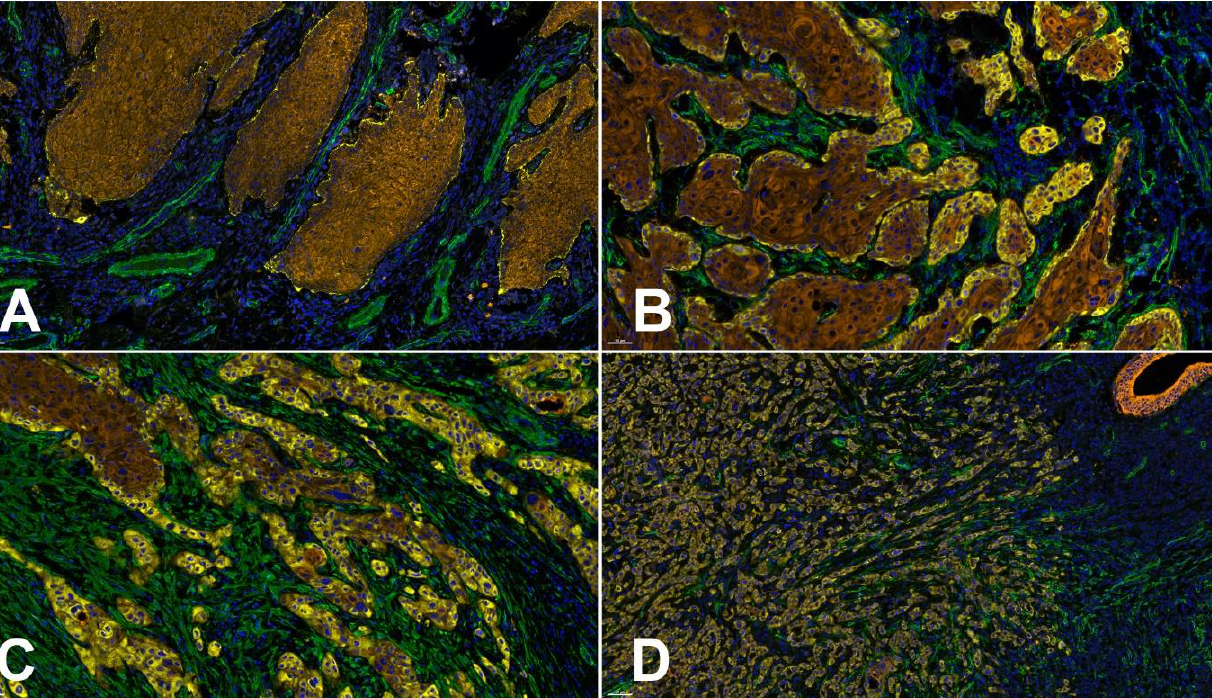
Figure 3. Different laminin gamma 2 chain (Lng2) deposition patterns in relation to the mode of invasion and the presence of myCAFs demonstrated by 4plex immunofluorescence staining using the Opal Multiplex Detection System from AKOYA Biosciences (full protocol available on request). The antibodies used were: clone B2 against Lng2 (Sc-25341, Santa Cruz Biotechnology, Inc., Heidelberg, Germany, yellow), clone 1A4 against alpha smooth muscle actin (aSMA) (IR611, Agilent Technologies Germany GmbH & Co. KG/DAKO, Hamburg, Germany, green), and clone AE1/AE3 against pan Cytokeratin (IR053, Agilent Technologies Germany GmbH & Co. KG/DAKO, Hamburg, Germany, brown). DAPI was used for nuclei counterstaining (blue). ( A ) OSCC with pushing well delineated infiltrating borders,, no aSMA-positive stromal fibroblasts (myCAFs), histopathological grade G2, a budding score of 1 according to the International Tumor Budding Consensus Conference (ITBCC 2021 [129]), and minimal basement membrane (BM) decoration for Lng2. ( B ) An OSCC showing infiltrating solid cords, clusters of myCAFs, histopathological grade G2, a budding score of 3 according to the ITBCC, and cytoplasmic accumulation of Lng2 in a few invasive disseminated OSCC cells in addition to positive marginal cells in more central parts of the tumor. ( C ) An OSCC with small groups or cords of infiltrating cells, myCAFs present in the whole invasive front, histopathological grade G3, a budding score of 3 according to the ITBCC 2021, and up to 50% Lng2-positive OSCC cells. ( D ) An OSCC showing a widespread dissemination of single tumor cells or small groups, an abundant presence of myCAFs, histopathological grade G3, a budding score of 3 according to the ITBCC 2021, and predominant Lng2-positive OSCC cells. Bar = 50 µ